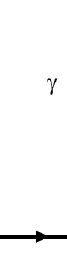
Figure 2. Sketch of the Vector Dominance Model. The electro- magnetic interaction is mediated by vector